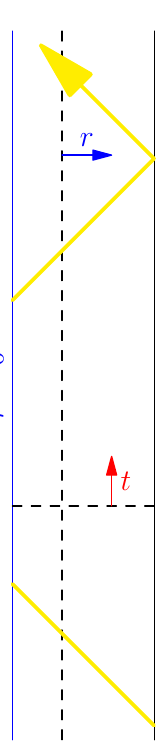
Figure 15. Empty AdS 3 with a radial light ray (depicted in yellow). The light ray appears discontinuous on the diagram because we have suppressed the angle ϕ : after reaching the center of AdS the light ray continues propagating in the antipodal part of the spacetime, reflects from the antipodal point on the boundary and re-emerges at r = 0 after time πR